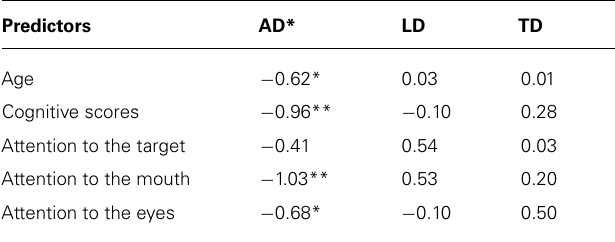
Table 4 | Linear regression beta weights and significance for latency to the target (where shorter times represent faster responses) within groups, factoring out cognitive scores and